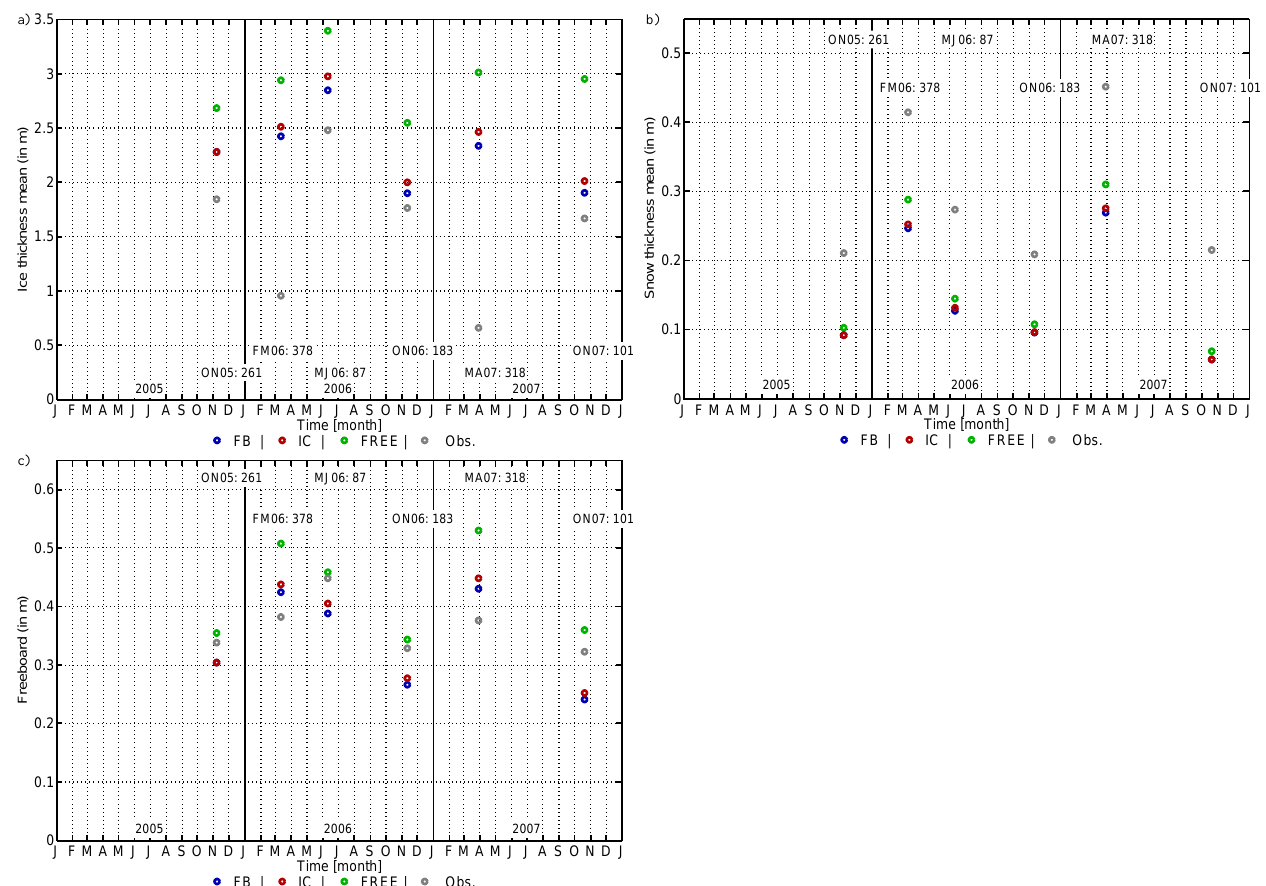
Fig. 12. Mean values of ice thickness (a) , snow depth (b) and ice freeboard (c) (green for FREE, red for IC and blue for FB) in the central Arctic at the same locations as ICEsat observations; observations are in light grey. Snow depth is extracted from ice freeboard data and sea-ice thickness (derived from ICEsat freeboard Kwok and Cunningham, 2008). Snow density is assumed constant (330kg m − 3 ). The numbers at the top of the plot are the mean number of data points available each day during the corresponding ICEsat